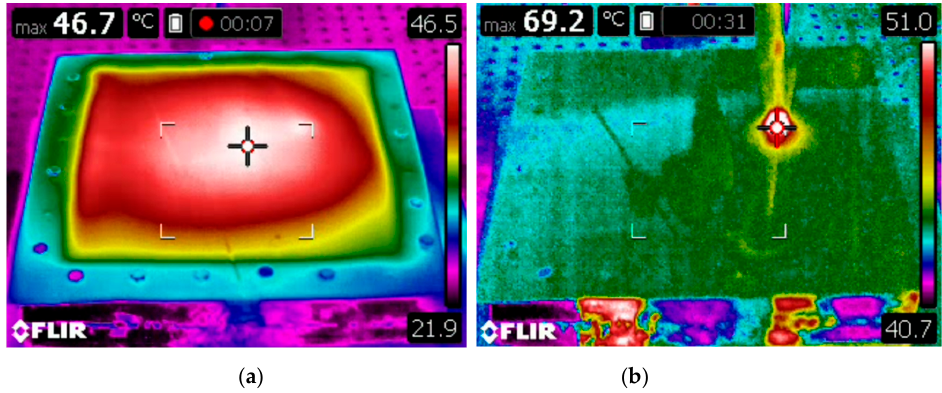
Figure 17. Thermal images of polymer sheet: ( a ) heated with air gun, ( b ) heated with advanced heating device. Figure 18 illustrates incrementally formed polymer sheets of different spatial geom- etry with processing parameters used during experiment which are listed in Table 6.